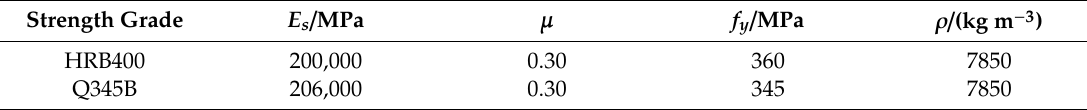
Table 5. Physical and mechanical parameters of the soil.